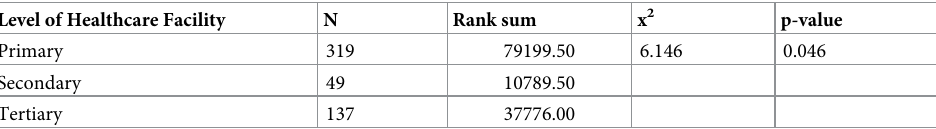
Table 8. Difference in EmONC integration by level of healthcare facility (n =